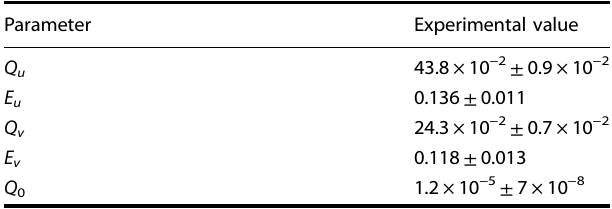
Table 1. Measured parameter of the decoy-state method used in the current experiment Parameter